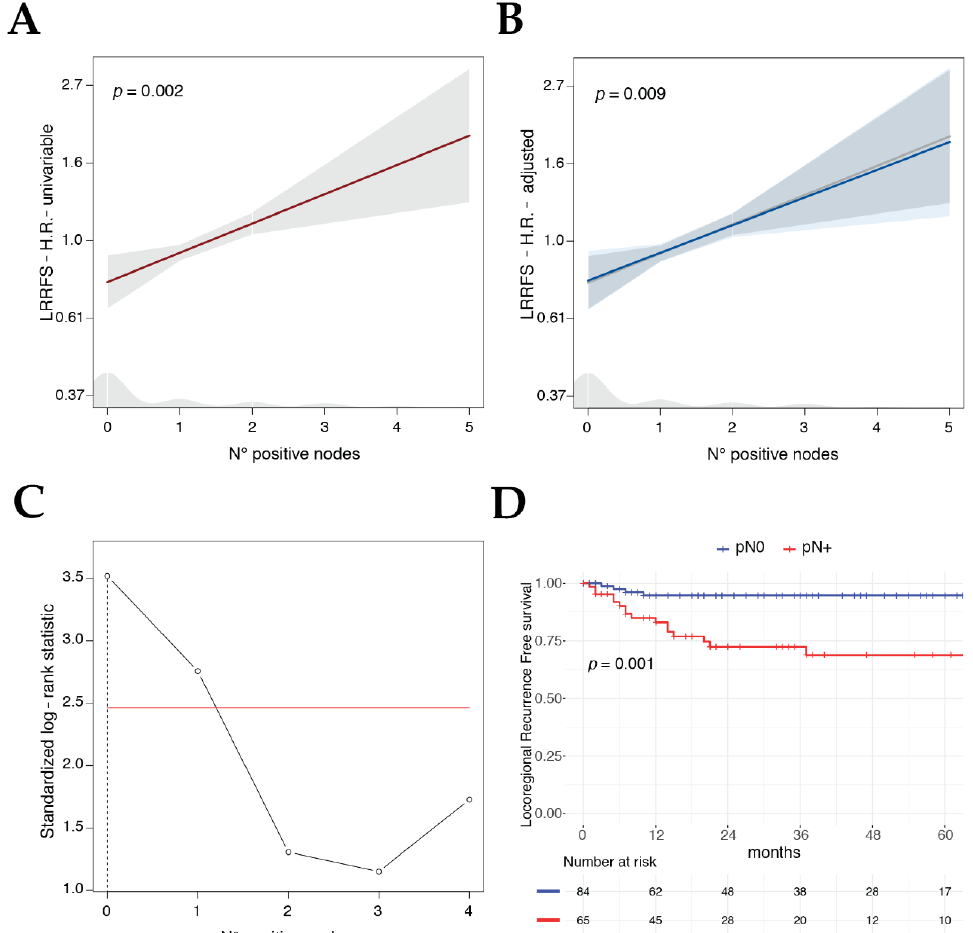
Figure 5. Plots showing the HR estimates and 95%CI (shadow area) of the number of histopathologic positive nodes derived from the univariable LRRFS Cox model ( A ) and from the multivariable one ( B ), adjusting the effect for pT category, tracheal involvement, and T-topography (gray line on the background refers to the univariable estimate). Plot of the standardized log-rank statistic, identifying 0 positive nodes as best cut-off for number of positive nodes for the prediction of LRRFS ( C ), red line indicating the adjusted significance level, vertical dotted line showing the best cut-off point. Kaplan–Meier curve of N status (N0 vs. N+) for LRRFS, p value adjusted for multiple tests showed ( D ).